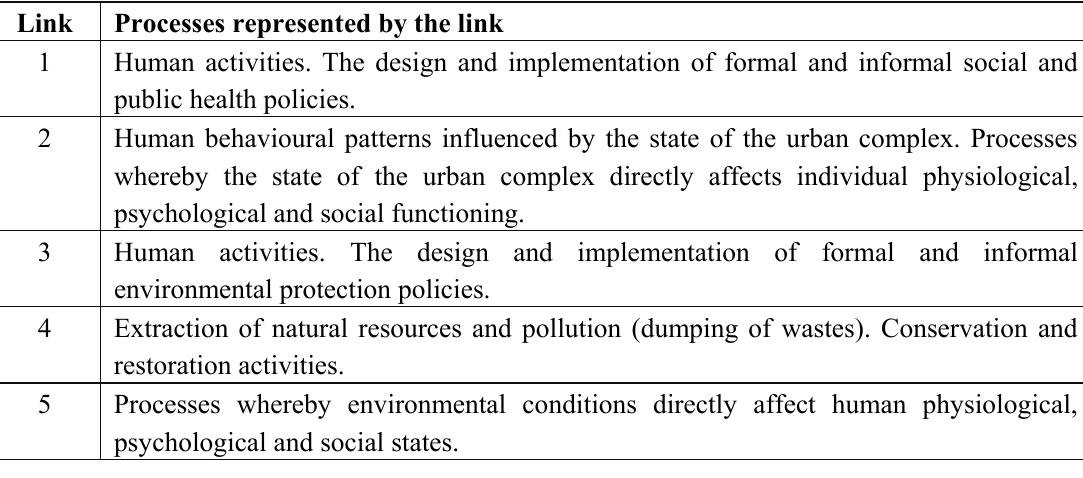
Table 2. The causal links of Figure